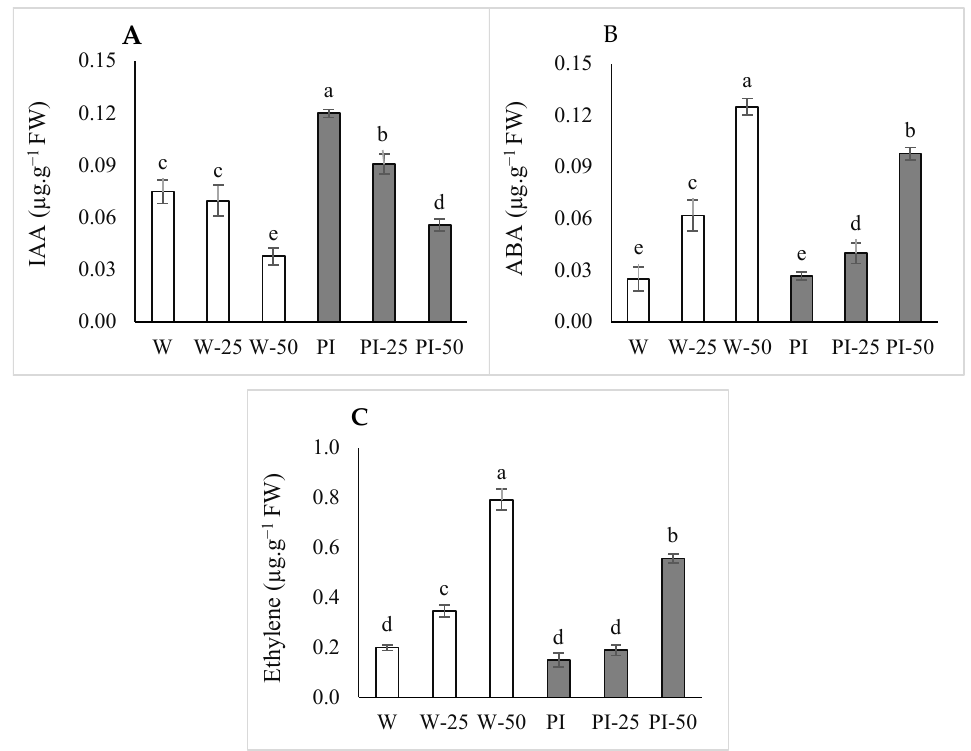
Figure 5. Hormone quantification ( A ) IAA, ( B ) ABA, ( C ) ethylene in leaves of cucumber plants grown under well and limited water irrigation regimes. W (normal irrigation), W-25 (moderate water stress; equal 25% less than normal irrigation), W-50 (severe water stress; equal 50% less than normal irrigation), PI (inoculation with P. indica under normal irrigation), PI-25 (inoculation with P. indica under 25% less than normal irrigation), and PI-50 (inoculation with P. indica under 50% less than normal irrigation). Data are means of combined analysis of two growing seasons. Means marked by the same lower-case letter are not significantly different ( p < 0.05). Error bars represent standard error of the means (SE), n = 6.